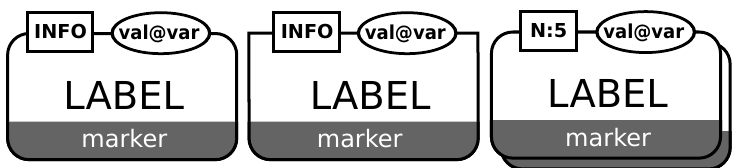
Figure 2.6: The Process Description glyph for labeled clone marker applied to a macro- molecule , a nucleic acid feature and a multimer of macromolecules .